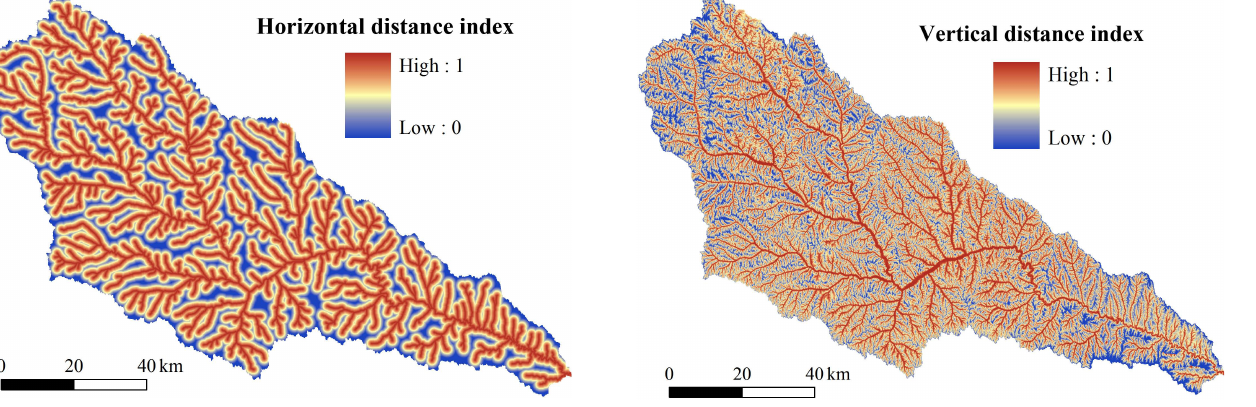
Fig. 6. Spatial distribution of the soil loss vertical distance index values in the Yanhe